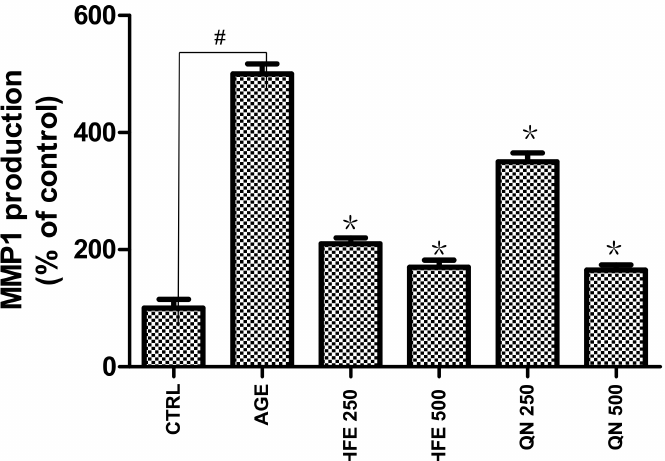
Figure 4. Effects of HFE and QN (quercitrin) on Matrix metalloproteinase 1 (MMP-1) expression in human skin keratinocyte (HaCaT) treated by advanced glycation end products (AGEs) for 24 h. Data are shown as the mean ± standard deviation (SD) of three independent experiments (Positive control: 24 h AGE-induced #: p < 0.05 compared to negative control; *: p < 0.05 compared to positive control by Student’s t